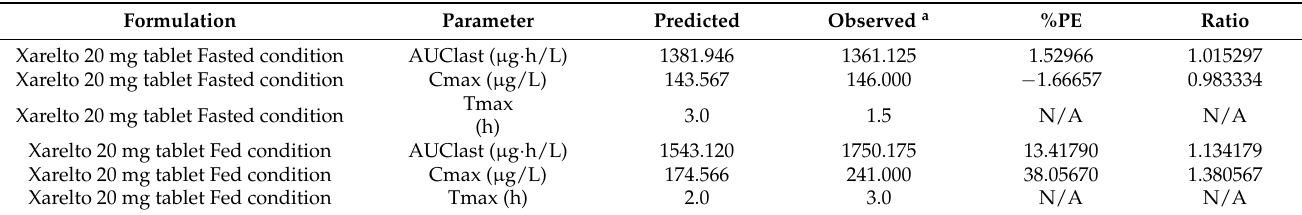
Table 8. Observed and predicted values of the internal validation (Xarelto 20 mg tablet fasted condition) and predicted values of theXarelto 20 mg tablet fed condition.